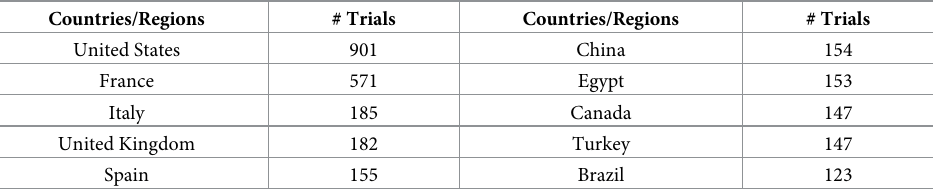
Table 2. The top 10 countries/regions with the most registered COVID-19 clinical trials.